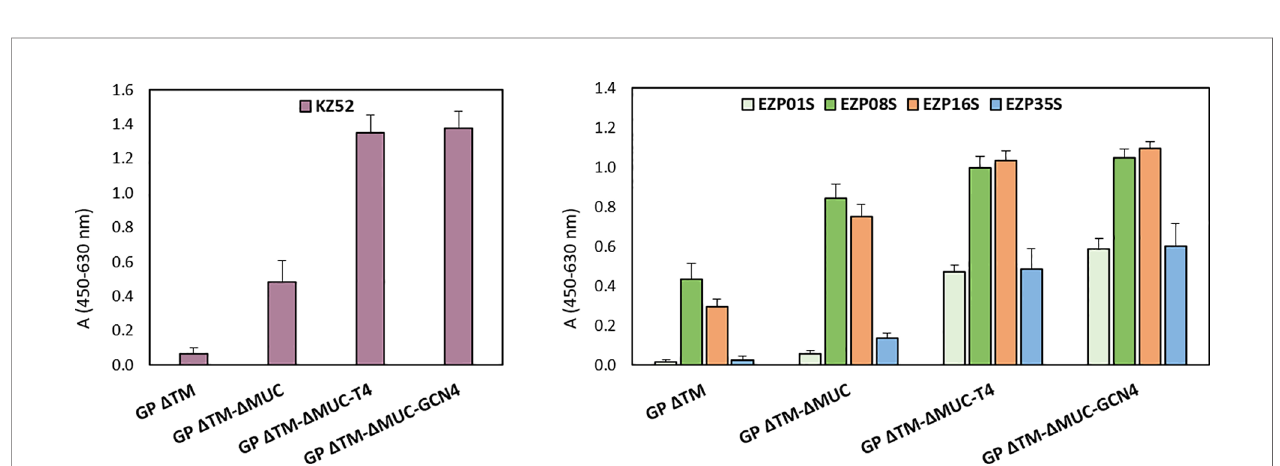
FIGURE 4 | Recombinant GP trimers show an increased breadth of reactivity with a panel of conformational mAbs. Sandwich ELISA analysis of GP D TM, GP D TM- D MUC, GP D TM- D MUC-T4, and GP D TM- D MUC-GCN4. The graphs show the results of the sandwich ELISA with human KZ52 (left) or a panel of mouse mAbs (right) as detection reagents. Average blank values were subtracted from sample values. Column heights represent the mean values of 3 independent assays, with corresponding standard